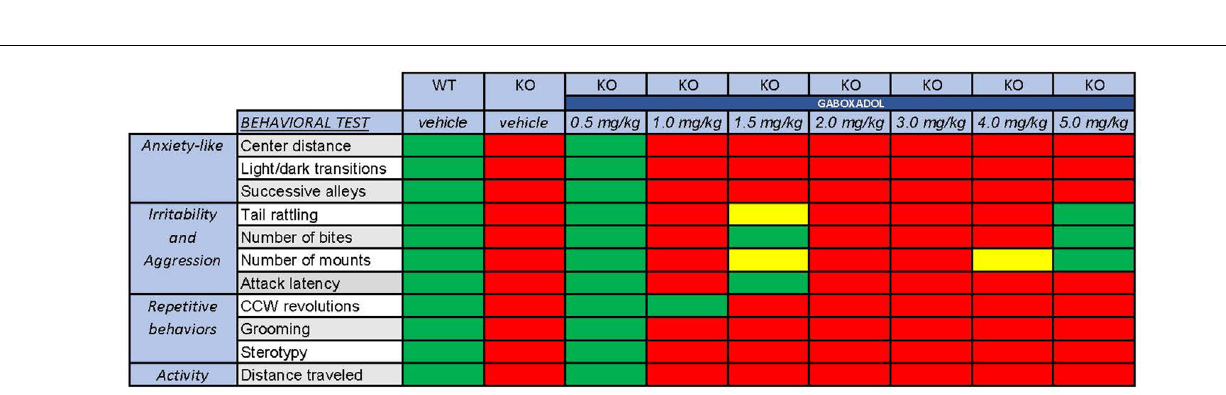
FIGURE 5 | Overall behavioral effects of gaboxadol in Fmr1 KO2 mice. Summary of the results of behavioral assessment of Fmr1 KO2 mice treated with vehicle or gaboxadol (0.5–5.0 mg/kg) compared to WT littermate controls. The Fmr1 KO2 mice showed significant phenotypes in locomotor activity, anxiety-related behaviors, irritability and aggression, and repetitive behaviors. All of these phenotypes were consistently normalized to WT levels by treatment with gaboxadol at the 0.5 mg/kg dose. “Normal” behavior (green squares) is consistent with WT vehicle-treated mice and is statistically different from Fmr1 KO2 (KO) vehicle-treated mice. “Abnormal” behavior (red squares) is consistent with Fmr1 KO2 (KO) vehicle-treated mice and is statistically different from WT vehicle-treated mice. Yellow squares indicate a difference that is either not significantly different from WT mice or statistically different from Fmr1 KO2 (KO) vehicle-treated